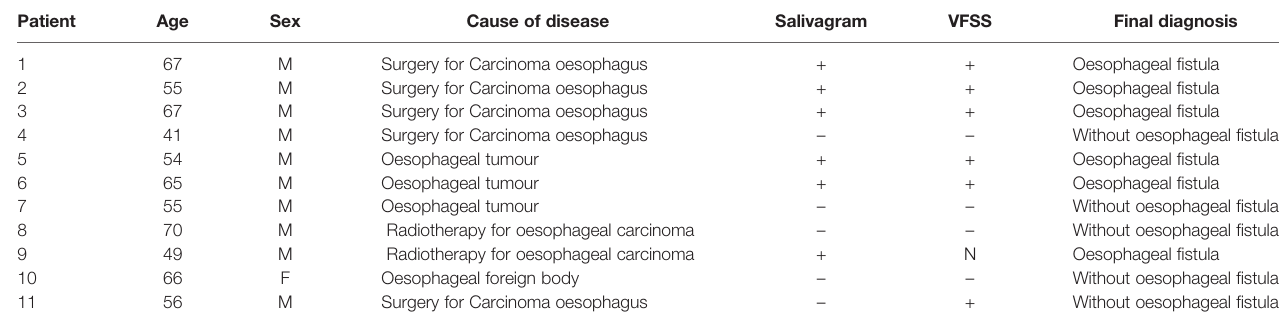
TABLE 1 | Basic patient information and results of salivagram and VFSS.